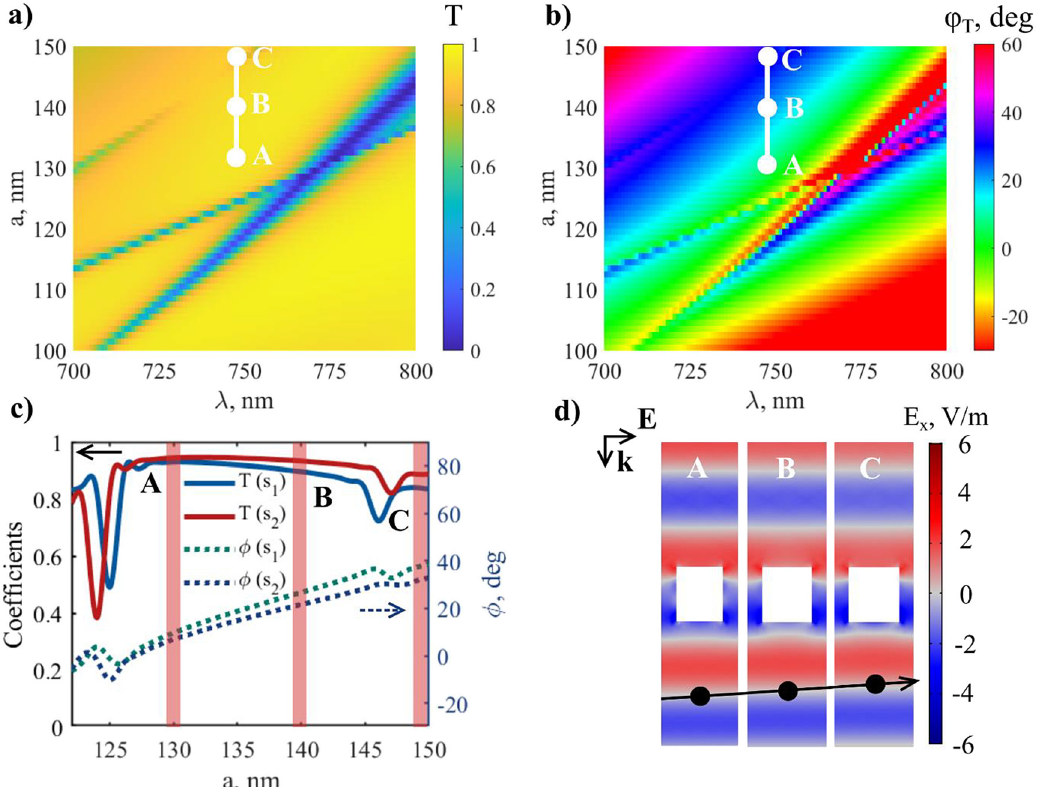
Figure 3: HA metasurfaces enabling phase control with the full transmission. (The height of the cylinders is kept constant at 370 nm) (a) Transmission as a function of wavelength and radius of the meta-atom, calculated at a fi xed, (arbitrarily chosen) wall-to-wall distance between cylinders s = 150 nm. The chosen range corresponds to the maximum available interval of radii featuring suppressed re fl ection ( λ = 750 nm). (b) The phase of the transmitted wave for the same parameters as in (a). (c) The lookup table of the proposed metalattice in the 0th diffractive order, calculated for two ultra-compact arrays with s = 100, 150 nm at λ = 750 nm. (d) From left to right: the x component of the electric fi eld in three metasurfaces constituted, respectively, of meta-atoms with radius a = 130, 140, and 150 nm, and transmitted phases ϕ = 10, 30, and 40 ° , selected from (b) (indicated with A, B, and C at λ = 750 T